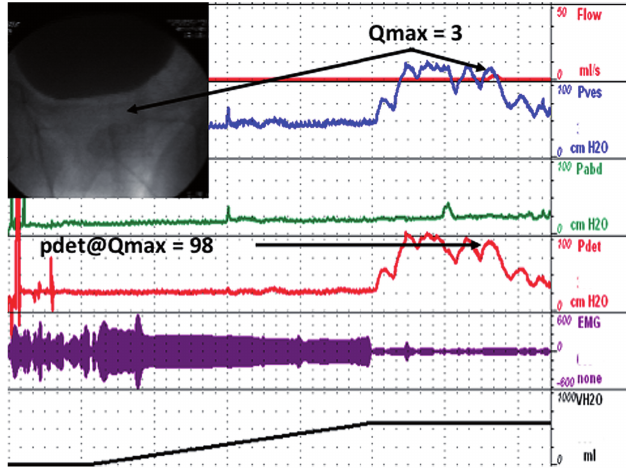
Patient with a strong, high pressure bladder contraction and obvious bladder